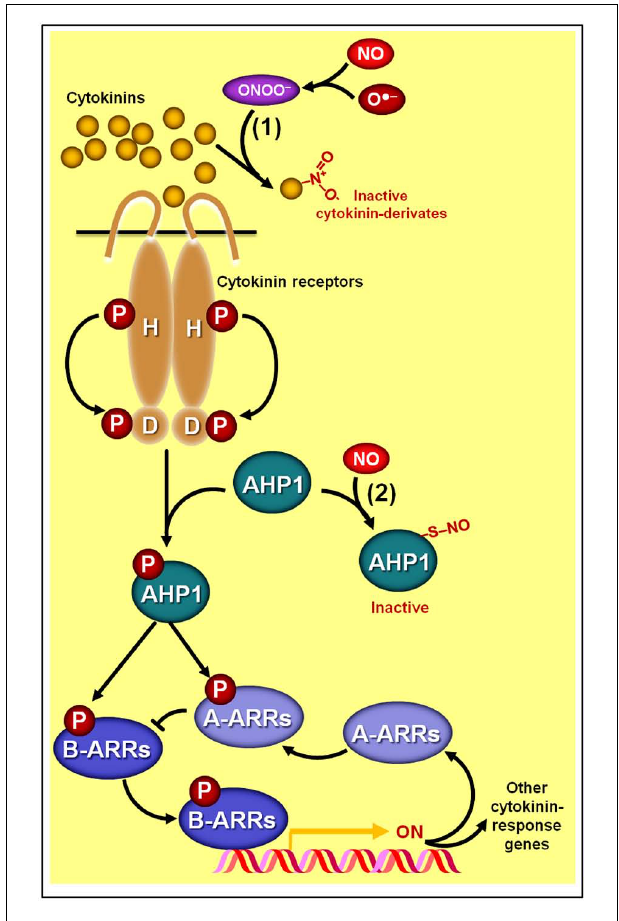
FIGURE 5 | Schematic representation of NO–cytokinin antagonistic interactions. (1) Certain cytokinin species such as zeatin may chemically react with peroxynitrite (ONOO − ), producing derivates with virtually no biological activity. (2) NO might also negatively impact cytokinin signaling since the protein HISTIDINE PHOSPHOTRANSFER PROTEIN 1 (AHP1), a key element in the phosphorelay mechanism involved in cytokinin transduction in Arabidopsis , may undergo S -nitrosylation at cys-115, rendering this protein incapable of transferring phosphoryl groups from the cytokinin receptors to the ARABIDOPSIS RESPONSE REGULATORs (ARRs). Protein S -nitrosylation and phosphorylation are represented by “–S–NO” and “P,”